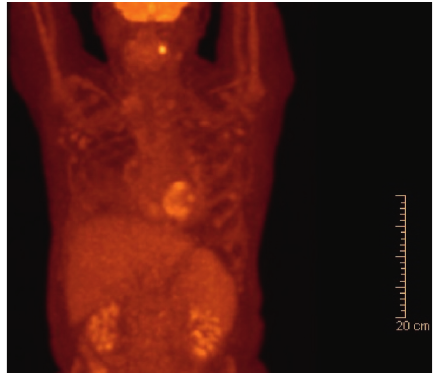
Figure 2: PETscan revealing the hypermetabolic focus localized to the left palatine